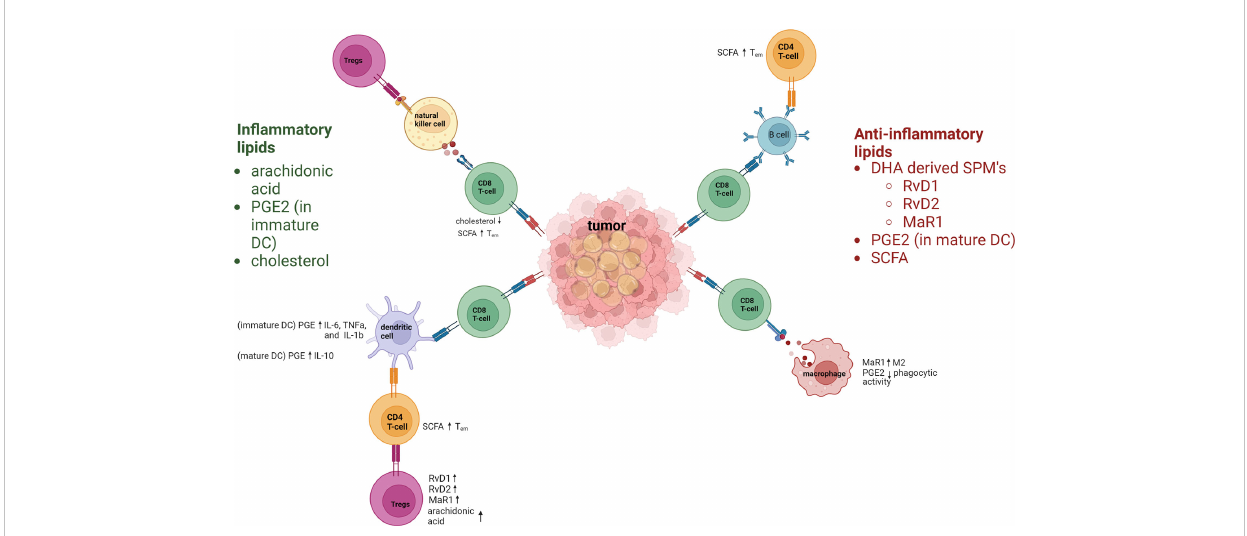
FIGURE 1 In fl ammatory and anti-in fl ammatory lipids regulation of the immune response. Lipids have key roles in regulating immune – in fl ammatory responses. In fl ammatory lipids include the polyunsaturated fatty acid arachidonic acid, PGE2, and cholesterol. Arachidonic acid hampers immune responses by increasing Tregs. PGE 2 increases in fl ammatory cytokines in immature DC. Cholesterol contributes to CD8 + T-cell dysfunction due to increases endoplasmic reticulum stress. Anti-in fl ammatory lipids include the specialized proresolving lipid mediators (derived from docosahexaenoic acid [DHA]) resolvins D1 and D2 (RvD1, RvD2), and maresin-1 (MaR1), all of which act via dendritic cells (DCs) to upregulate T regulatory cells (Tregs). PGE2 and short-chain fatty acids (SCFA) are also anti-in fl ammatory lipids that regulate immune cells. SCFAs increase the effector memory phenotype of T cells. Macrophages are polarized towards M2 by MaR1, and macrophage phagocytic activity is downregulated by PGE2. PGE2 also upregulates IL-10 in mature